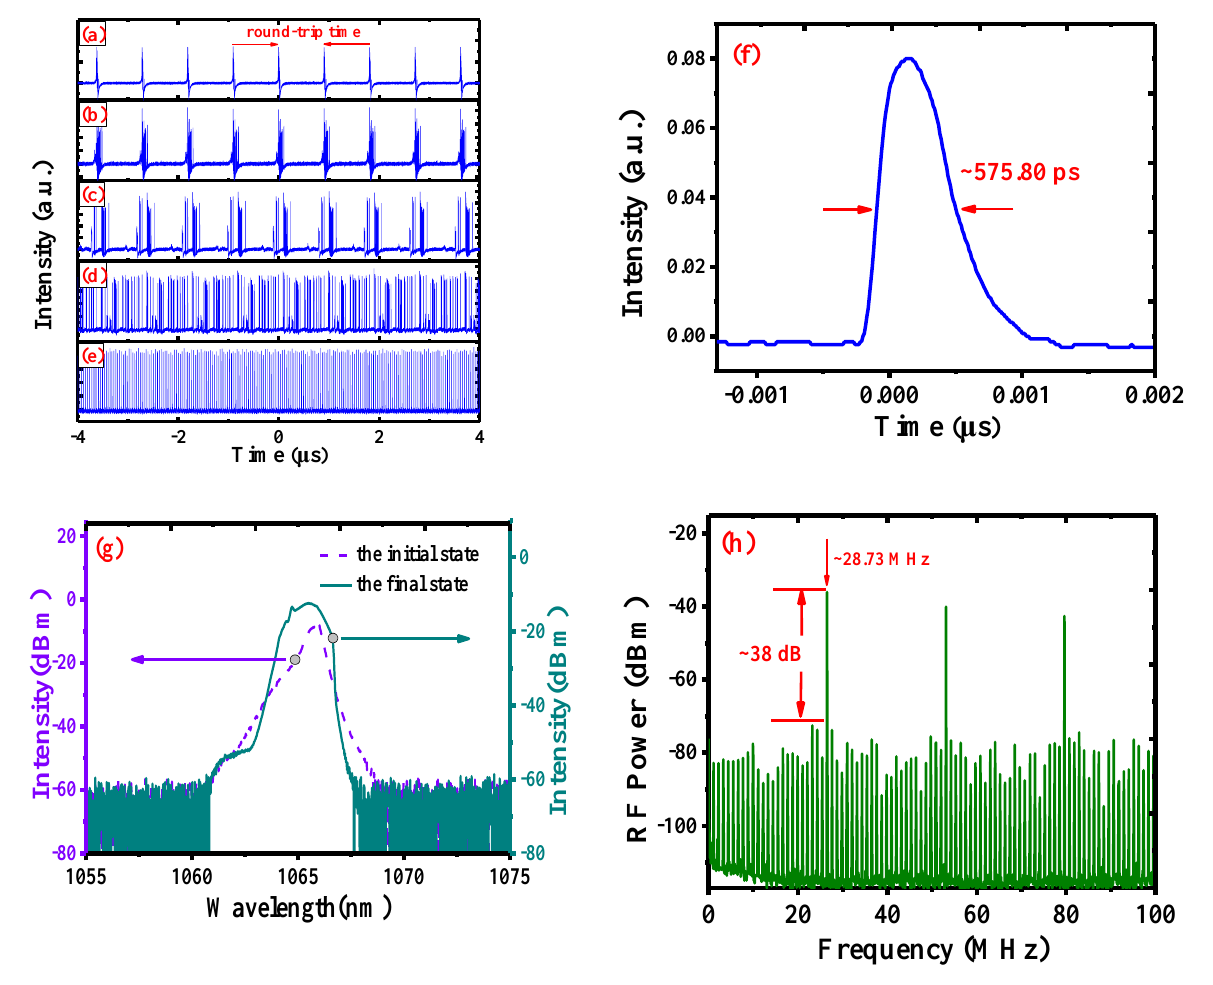
Figure 7. ( a–e ) the transition from a bunched state to the 26 th -order HML. ( f ) the single pulse of 26th-order HML. ( g ) Optical spectra of initial and final state. ( h ) The corresponding RF spectrum of 26th-order